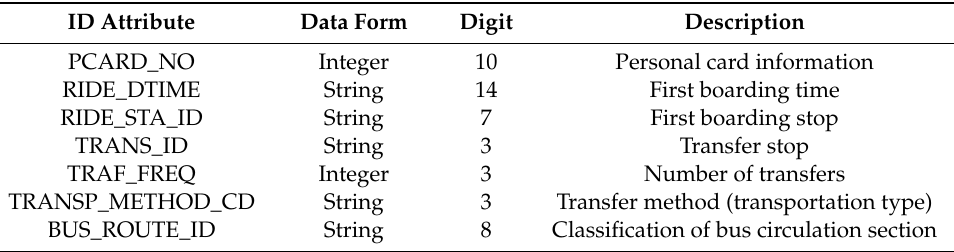
Table 2. Structure of transportation card data.